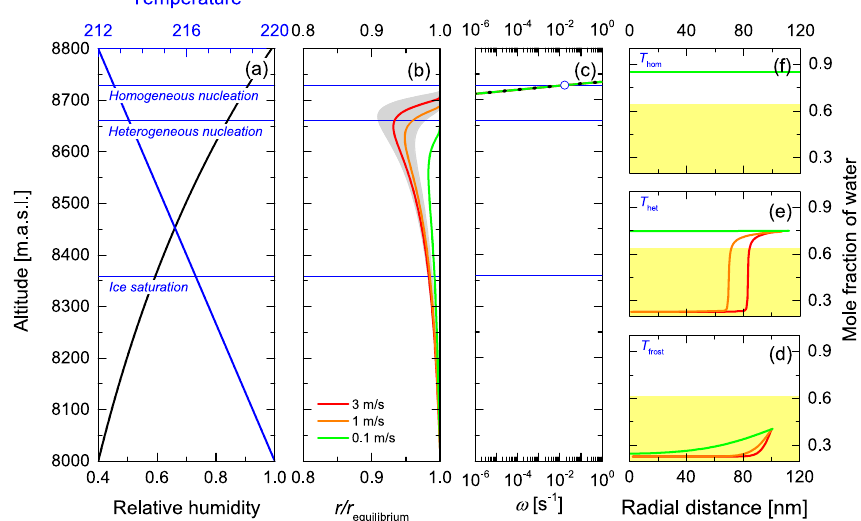
Figure 4. Simulation of secondary organic aerosol particles with an initial radius of 100nm in an air parcel experiencing adiabatic updraft conditions typical of the upper troposphere in mid-latitudes below 220K. (a) Air parcel temperature (blue line, top scale) and relative humidity (black line, bottom scale). (b) Ratio of modeled radius over thermodynamic equilibrium radius when experiencing 0.1 (green line), 1 (orange line) and 3ms − 1 (red line) linear updraft velocities. The gray shaded area indicates the effect of ± 1 order of magnitude difference in the water diffusivity in the pure α -pinene SOA for an updraft velocity of 3ms − 1 (see also gray shaded area in Fig. 3). (c) Homogeneous ice nucleation rates, ω , in the current case overlapping with each other and with equilibrium conditions (black dashed line). Also shown are the water concentration profiles upon reaching (d) ice saturation at the frost point, T frost , (e) heterogeneous ice nucleation conditions typical for SOA particles (Berkemeier et al., 2014), and (f) homogeneous ice nucleation conditions, i.e. the altitude where the black dotted line in panel (c) is equal to 1min − 1 , marked by the blue circle. Since the particles are well equilibrated under these conditions for all updraft velocities, the concentration profiles in panel (f) overlap with each other. The yellow areas indicate the concentrations at which the mixtures are in the glassy state.